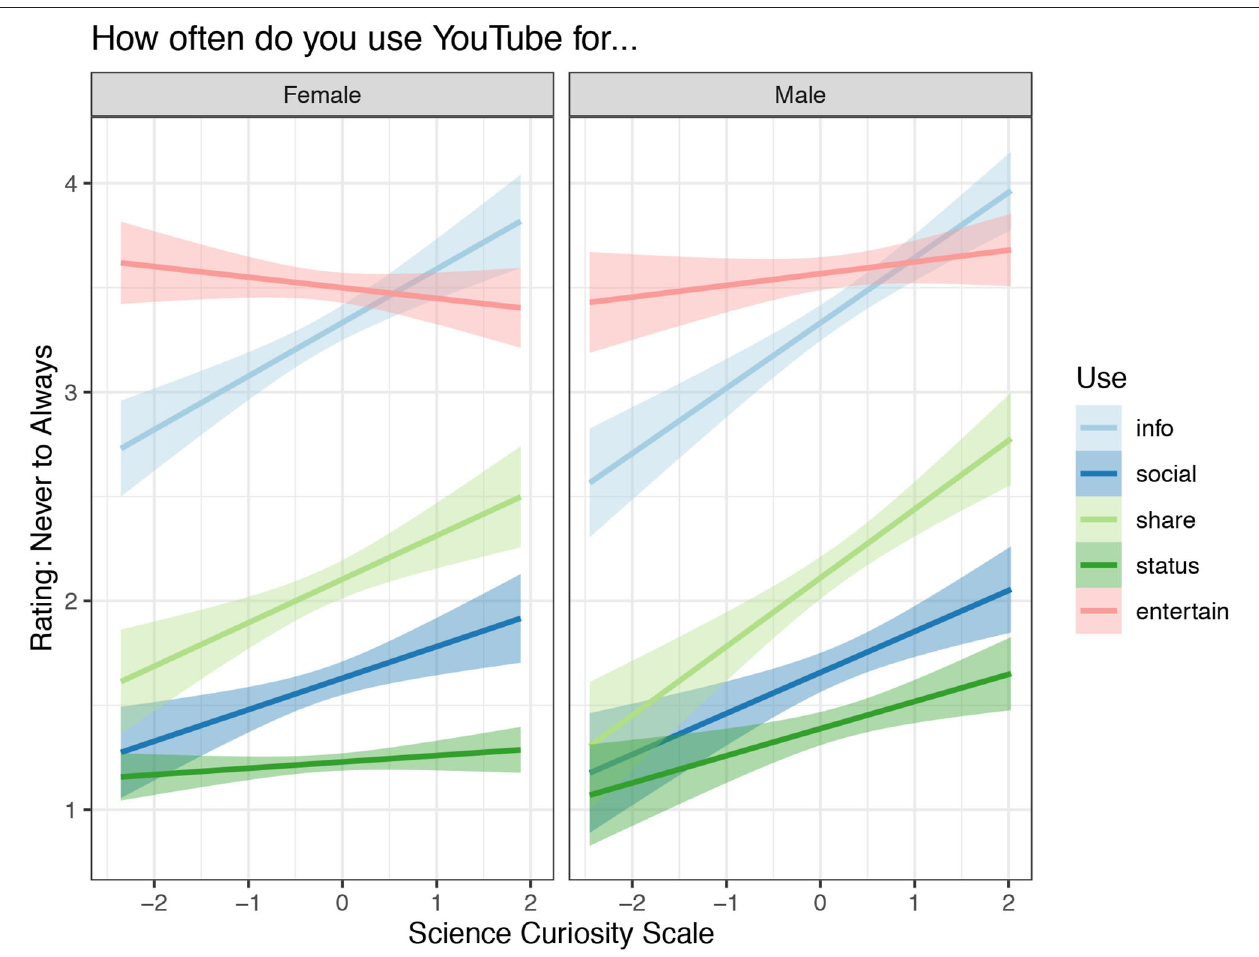
FIGURE 4 | Predicting each of the five uses and gratifications of YouTube from participants’ science curiosity scores by gender. Among our sample participants, science curiosity does not predict using YouTube for entertainment purposes, but this was the most common use among participants. reported watching a health and wellness video than men, = 12.97, p < 0.001. Finally, 166 participants (79 female) χ 2 (1) reported that at least one of the videos they watched was an entertainment video. A chi-square test suggested no difference in the likelihood of having categorized one of the three videos as an entertainment video based on participants’ gender, χ 2 p =